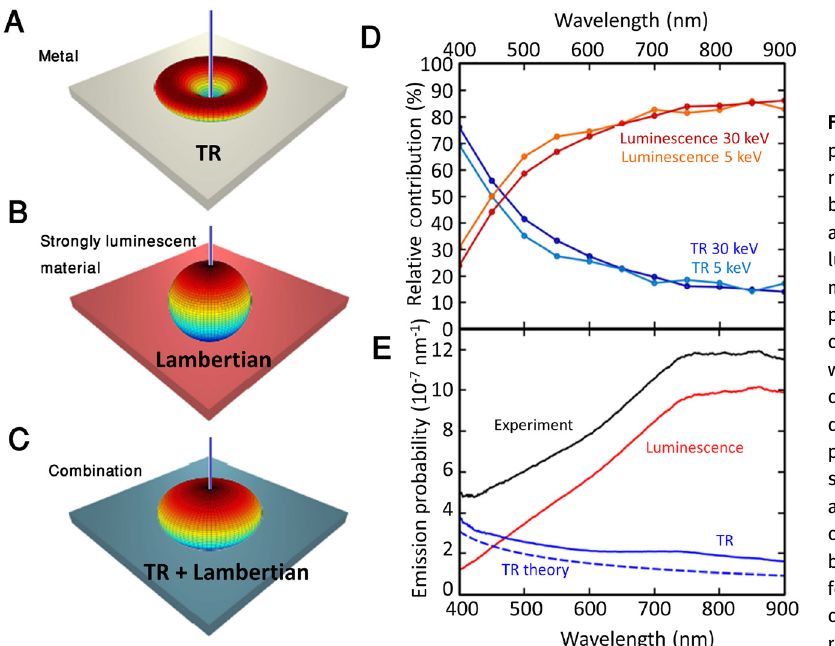
Figure 3: (A) Schematic angular emission profile for electron beam – induced radiation from a metal, which is dominated by transition radiation (TR). (B) Schematic angular emission profile for incoherent luminescence generated inside the material with a Lambertian emission profile. (C) Schematicemission profile for a combination of TR and luminescence, which is the case for Si. (D) The relative contribution of TR and luminescence derived from fits to the silicon emission pattern for 5 and 30 keV energy. (E) The CL spectrum (black) together with TR (blue) and incoherent luminescence (red) contribution for Si at 30 keV. The dashed bluelinesshowthetheoreticalTRspectrum cathodoluminescence; TR,